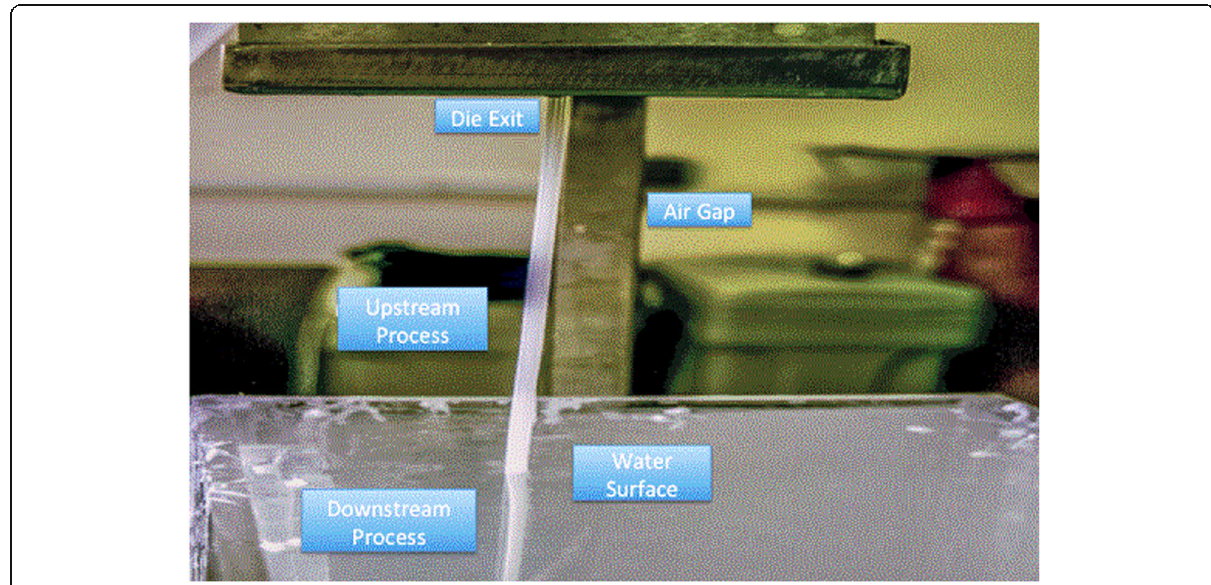
Fig. 8 Stable extrusion from die exit into water coagulation